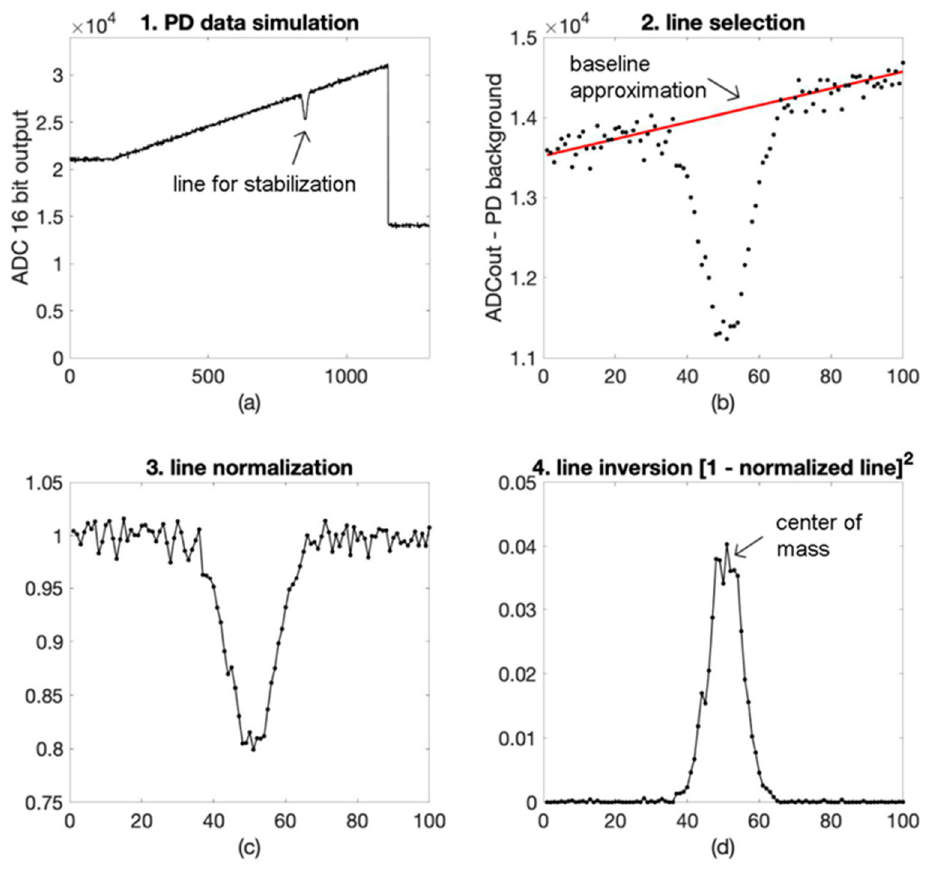
Figure 7. Real-time line center search algorithm visualization. ( a ) simulation of photodiode data for algorithm verification; ( b ) slice of original data with deducted background radiation; ( c ) line after normalization; ( d ) final result for the center of mass calculation.